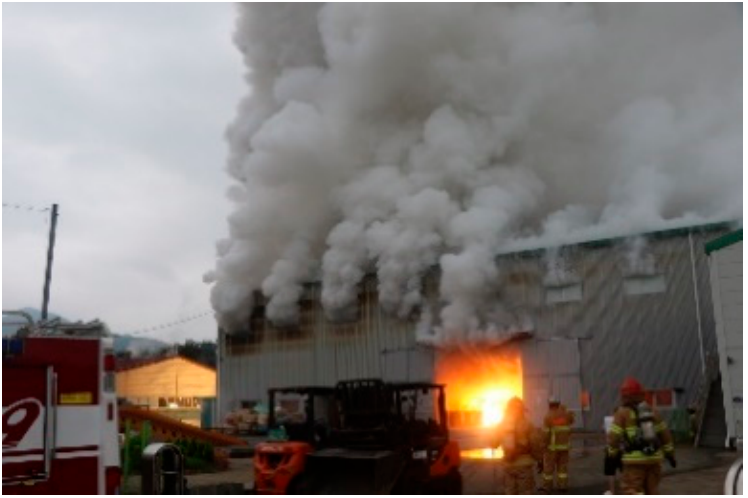
Figure 2. Fire in a magnesium recycling plant (2019) (Photo by Miryang fire department).